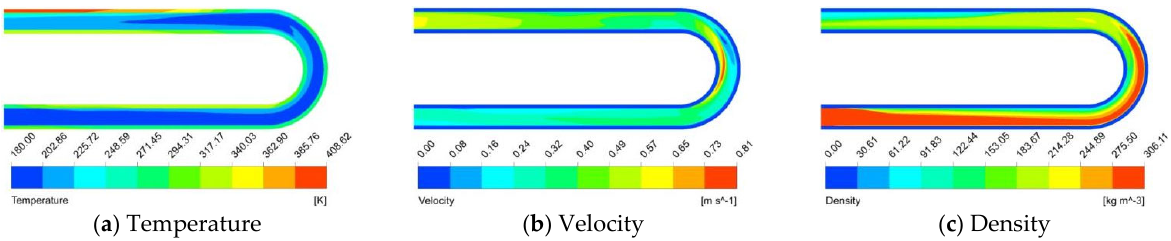
Figure 8. Physical quantities’ distribution contour in the U ‐ tube heating section: ( a ) Temperature, ( b ) Velocity, ( c ) Density.